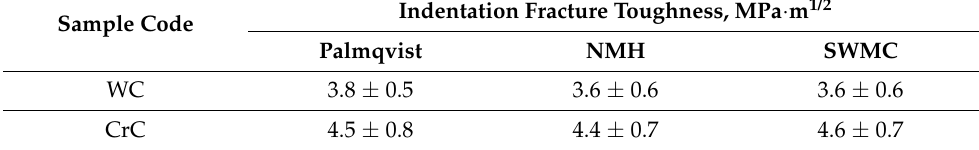
Table 7. Indentation fracture toughness of composite coatings sprayed by the high-velocity oxygen fuel (HVOF)